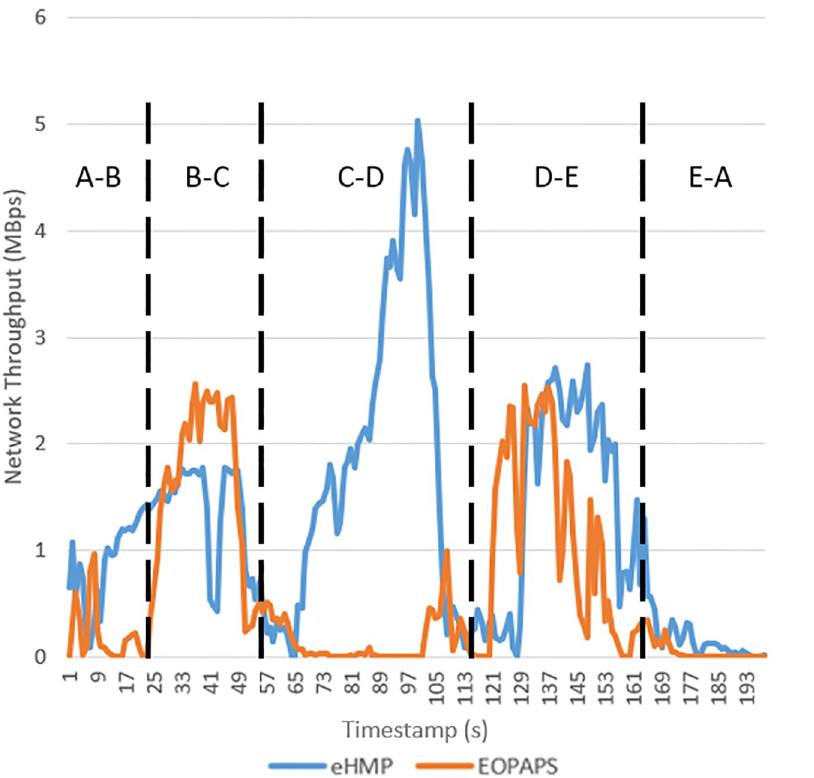
Fig 21. Comparison of network throughput between eHMP and EOPAPS.